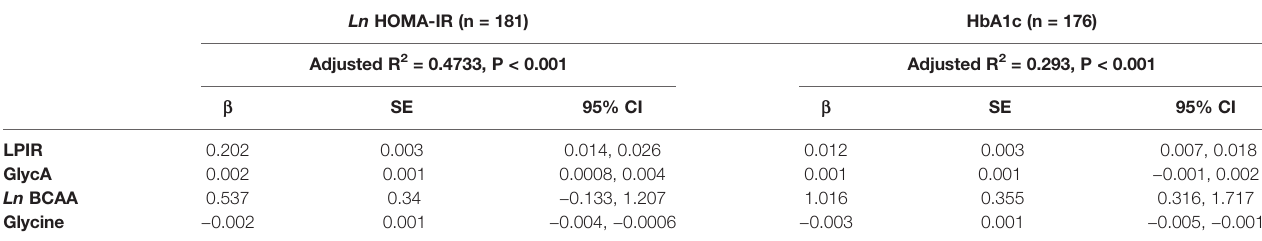
TABLE 2 | Association of NMR-derived biomarkers with HOMA-IR and HbA1c. Ln HOMA-IR (n = 181) HbA1c (n = 176) Adjusted R 2 = 0.4733, P < 0.001 Adjusted R 2 = 0.293, P <